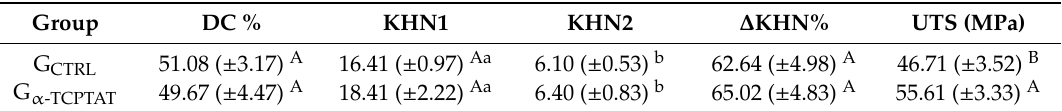
Table 1. Mean and standard deviation values of degree of conversion (DC %), microhardness before (KHN1) and after (KHN2) the immersion in the solvent, the variation of microhardness ( ∆ KHN%) and ultimate tensile strength